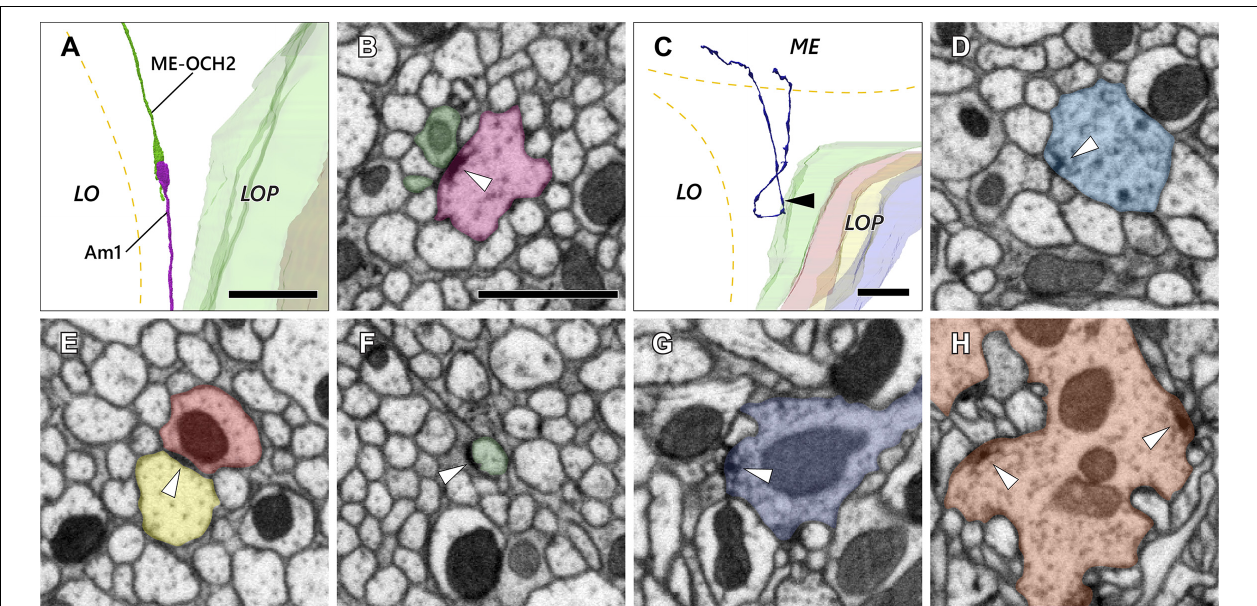
FIGURE 5 | Axon and synaptic ultrastructure in the chiasm. (A) An Am1 branch and a ME-OCH2 cell terminal, both terminating in OCH2. (B) The two cells shown in (A) form a synaptic contact within OCH2. The two sites of synaptic contact are revealed where the Am1 terminal (red), forms a T-bar ribbon (arrowhead), which is presynaptic, opposite the ME-OCH2 terminal (green) where it is postsynaptic. (C) Part of a DCV cell making a reverse turn in OCH2. Its ME part is incompletely reconstructed. (D) A synaptic site of the DCV cell shown in (C) . The synaptic site corresponds to the point indicated by the arrowhead in (C) . The DCV cell has a presynaptic T-bar (arrowhead) and provides input to a dyad of postsynaptic Tm cell axons. (E,F) Putative septate or adherens junctions in OCH2. (E) is a case between Tm cell axons, and (F) is a case between a Tm cell axon and glia. (G,H) Typical presynaptic T-bars found outside OCH2. (G) is an example of a Tm1 cell, while (H) is a Tm9 cell terminal, both in the first stratum of the lobula. Scale bar: (A,C) : 10 µ m; (B) , (D–H) : 1 µ